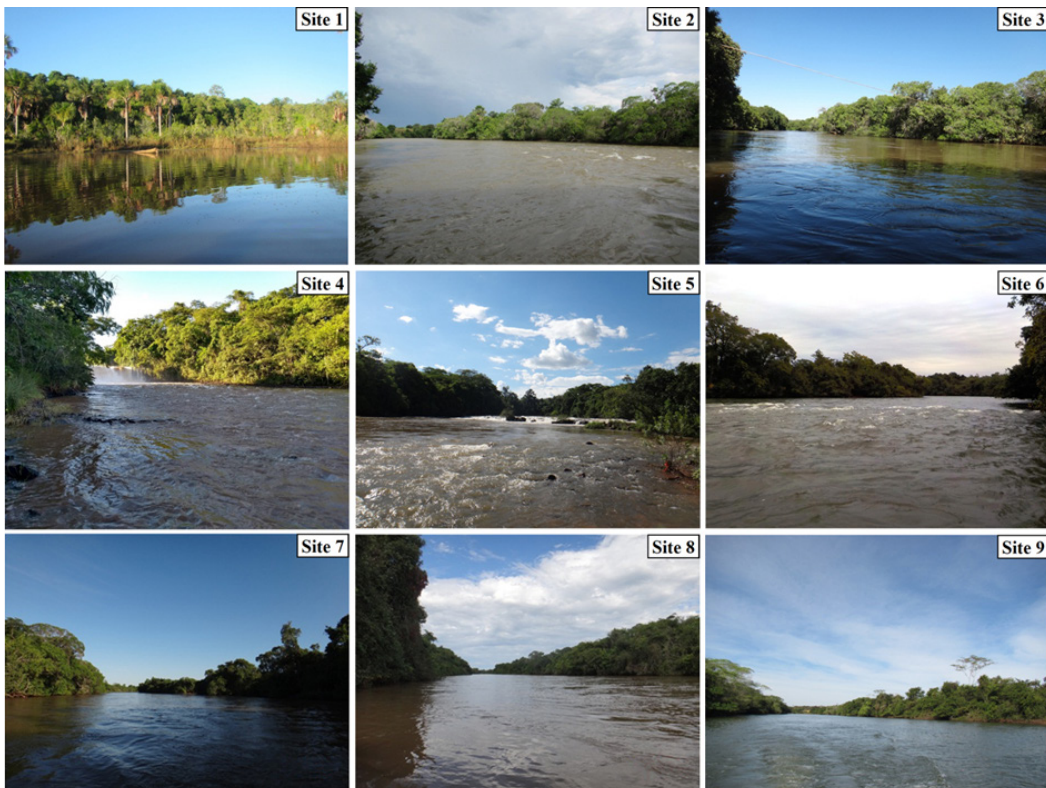
Figure 2. Collection sites in the Aporé River, Paranaíba River basin. Lentic (Site 1) and lotic (Sites 2-9)